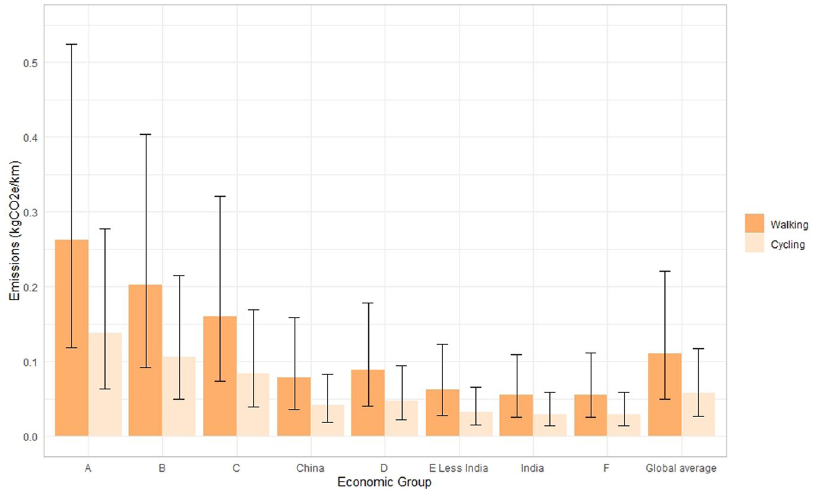
Figure 1. Emissions associated with travelling a kilometre, by walking, and cycling, assuming full energy compensation for countries grouped by level of economic development (from most economically developed (A) to least economically developed